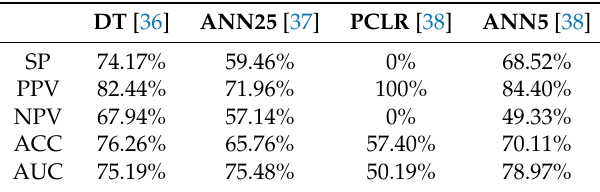
Table 12. Performance indicator versus technique using hold out validation with HMS criteria.